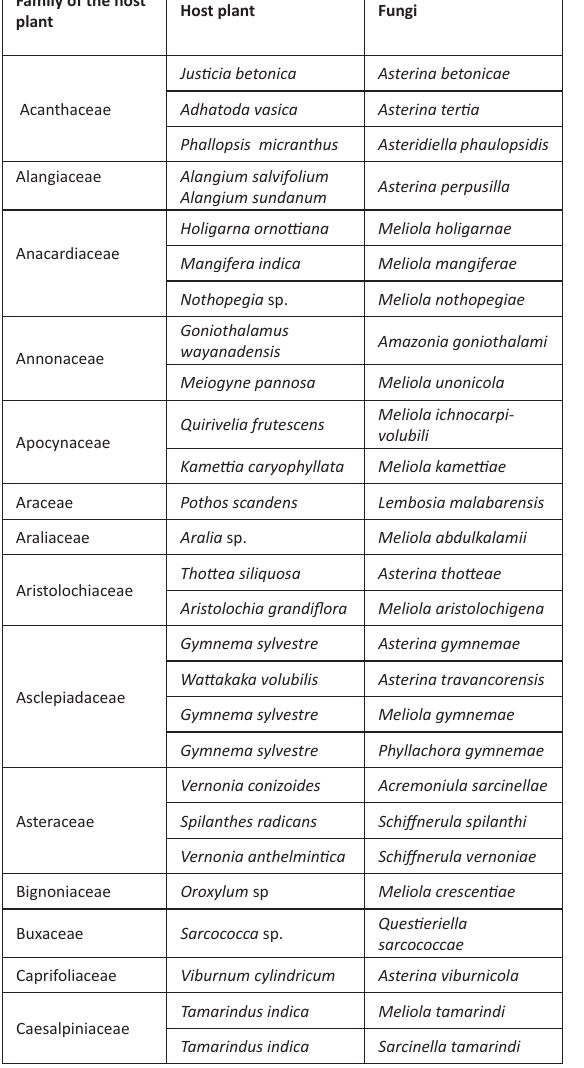
Table 2. Host family, host and